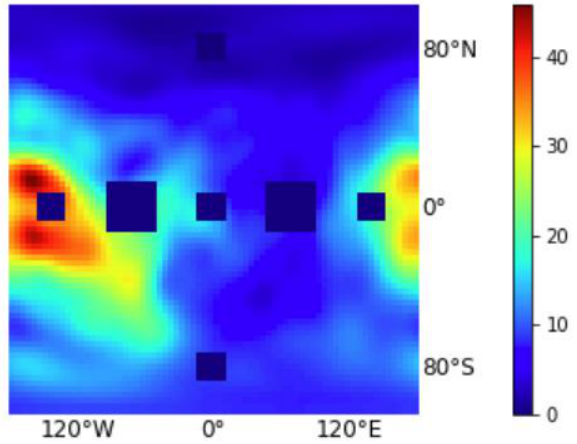
Figure 3. Selected patterns for spatial TEC estimation. The network frameworks for the DCGAN and WGAN-GP remained the same as above; the input dimension was 72 × 72 × 1, and two additional convolution structures were added for the generator to maintain consistency in the dimensions during the training procedure. The well-trained models were then used to test the data from 2009, 2014, and